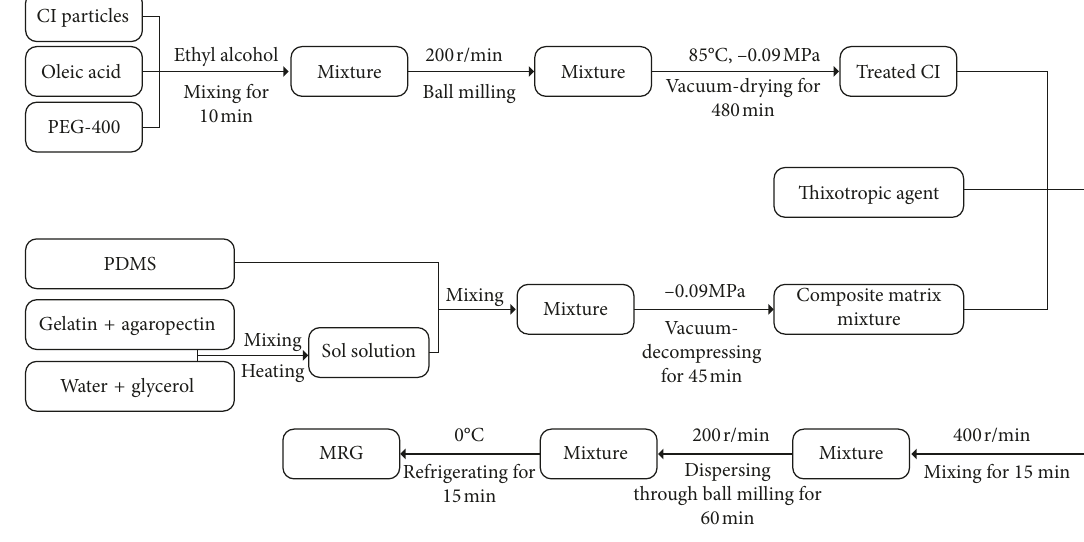
Figure 1: The preparation process of MRG. Table 1: The composition of MRG samples (mass fraction).